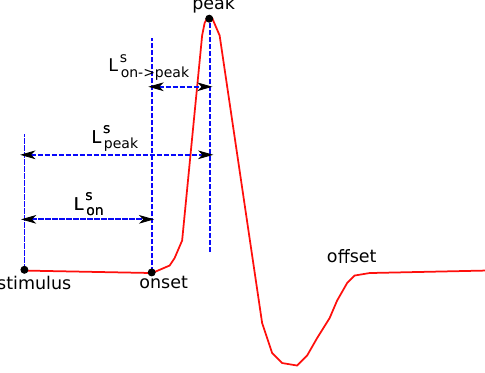
Figure 3. Several features related to definitions about duration.